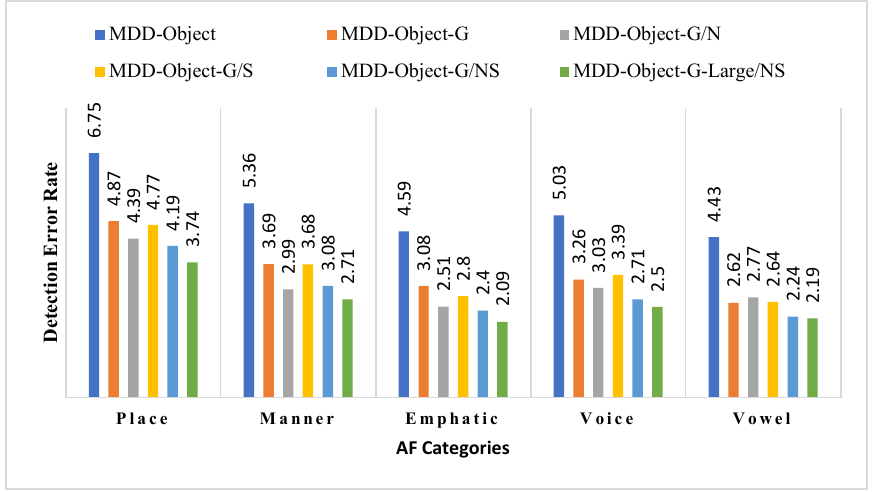
Figure 7. Detection error rate (DER) for each AF category using our proposed models.